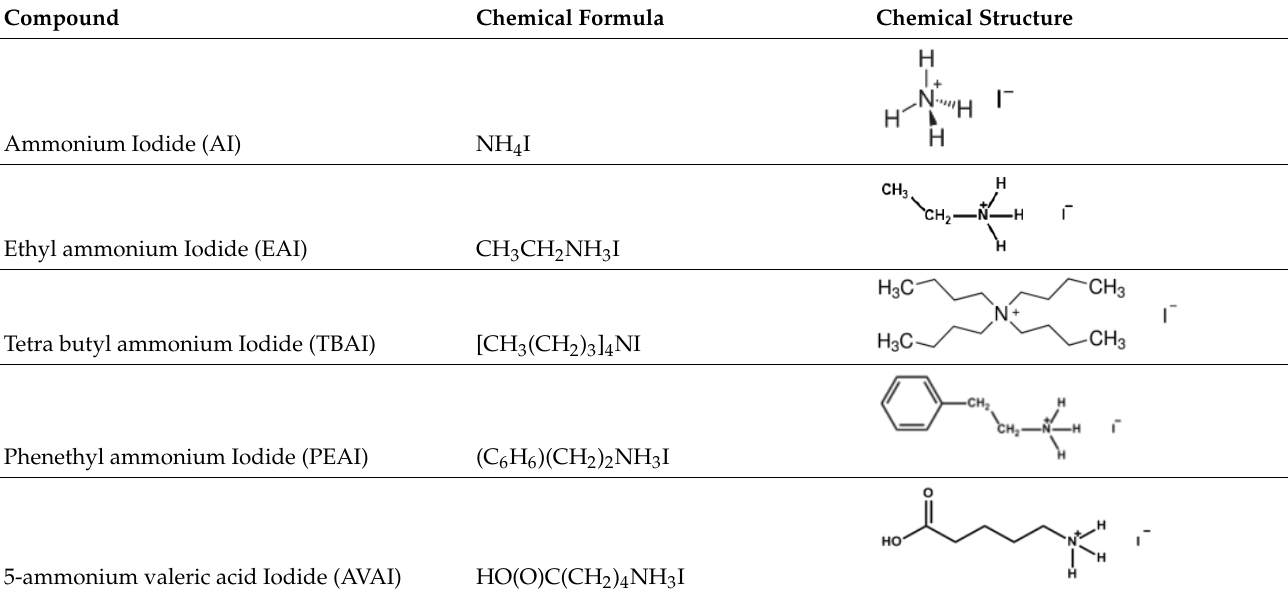
Table 9. Chemical formulas and structures of the ammonium iodides. Compound